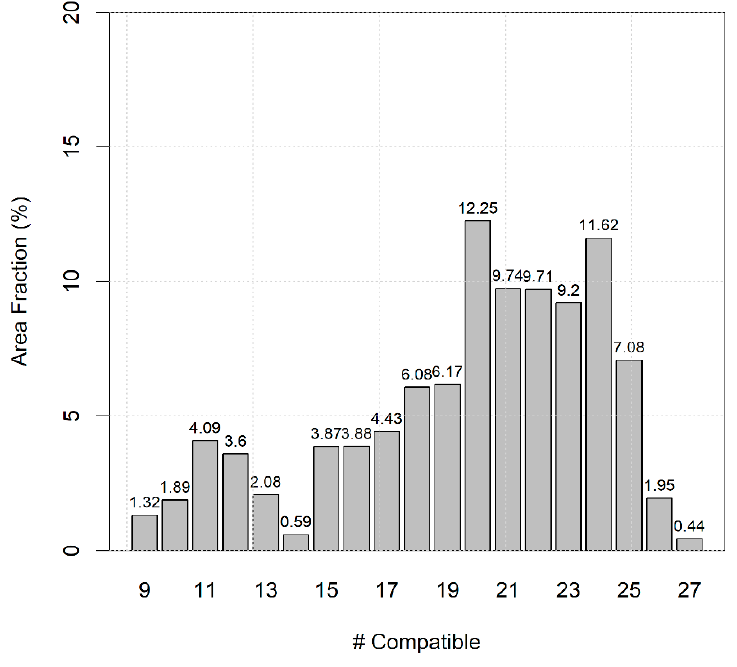
Figure 4. Area fraction of the number of compatible constituents within Dockum-HSU for municipal uses.